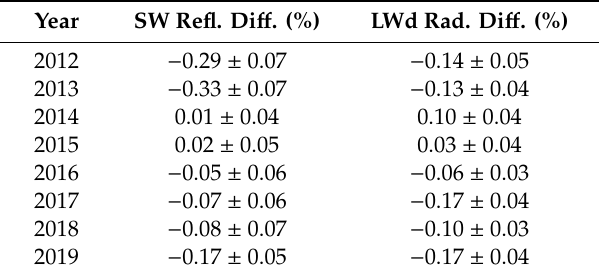
Table 5. Di ff erences in the global average of all-sky SW reflectance and daytime LW (LWd) radiance between SNPP / FM5 preEdition-2 and Aqua / FM3 Edition-4, for the years 2012–2019. Di ff erences shown are FM5-FM3, expressed as a percentage along with the 95% confidence